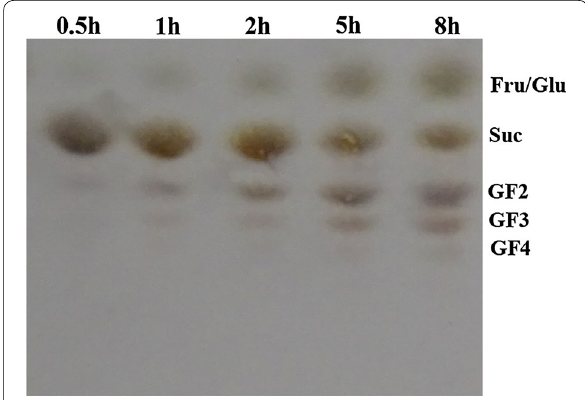
Fig. 5 TLC analysis of the FOS composition formed during the trans-